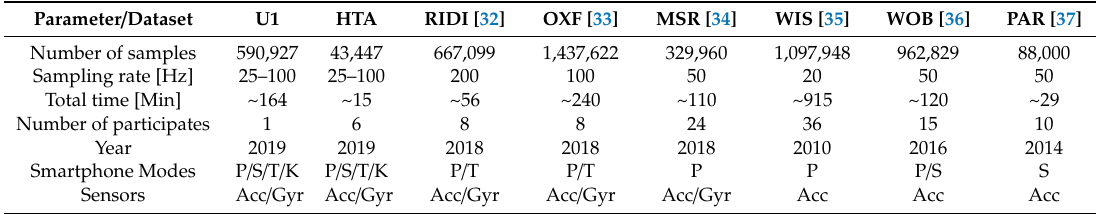
Figure 8. Dataset U1 sample’s distribution to each smartphone location. Table 2. Main parameters of all eight datasets used in the analysis. Smartphone locations are pocket (P), swing (S), texting (T), and talking (K). Sensors are accelerometers (Acc) and gyroscopes